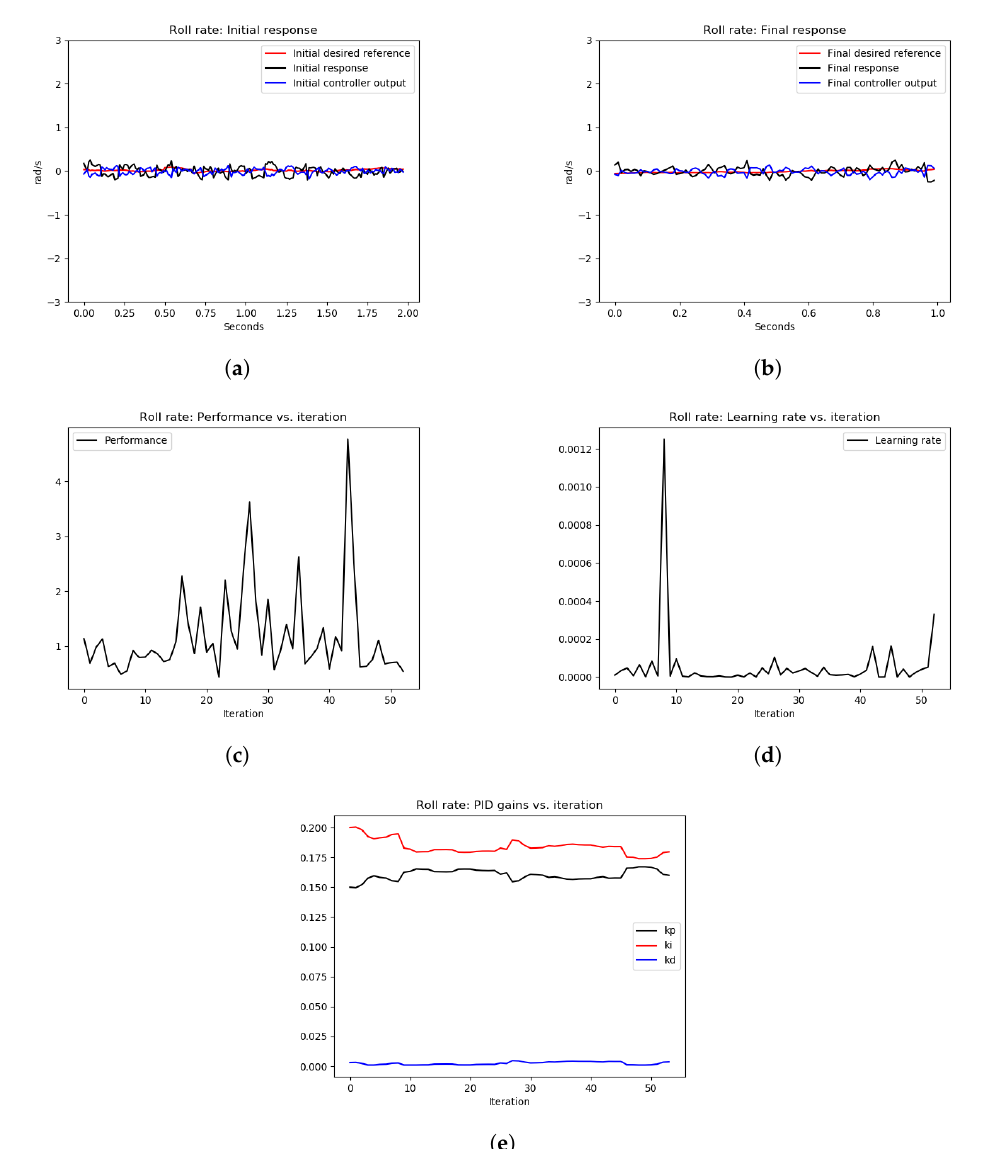
Figure 12. The results of the tuning process of the roll-rate PID controller in Experiment 1. ( a ) signals before tuning, ( b ) signals after tuning, ( c ) performance error V ( E ) over iterations, ( d ) learning rate α over tuning iterations, ( e ) PID